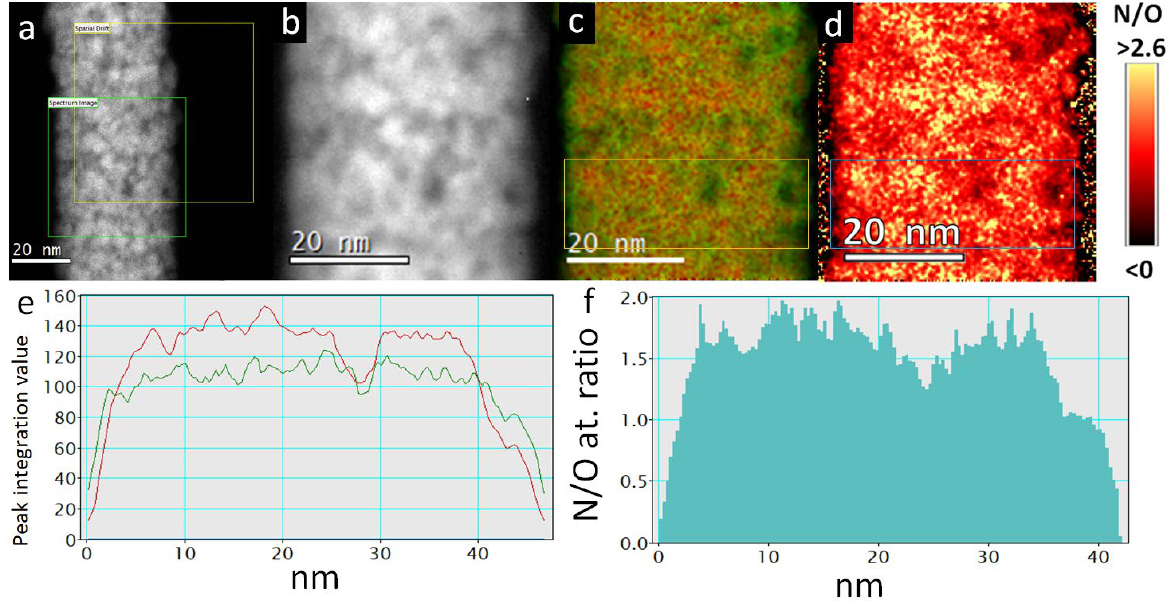
Figure 6. Electron energy loss spectroscopy (EELS) mapping of a TiON/C-CNF2. ( a ) STEM-HAADF image of the chosen locations for EELS mapping (in green) and spatial drift monitoring (in yellow), ( b ) the mapped area with EELS mapping (each pixel is a whole EELS spectrum), ( c ) N and O edges extracted EELS mapping image with more nitrogen content in red and more oxygen content in green (smoothed image), ( d ) N/O at. ratio in every pixel as a colour (smoothed image), ( e ) a line profile of the image c with an integrated width 15 nm (marked with an orange square on image ( c )), where the red line represents N and the green line represents O edge integration value, ( f ) a line profile of the image c with an integrated width of 15 nm (marked with a blue square on image ( d )).